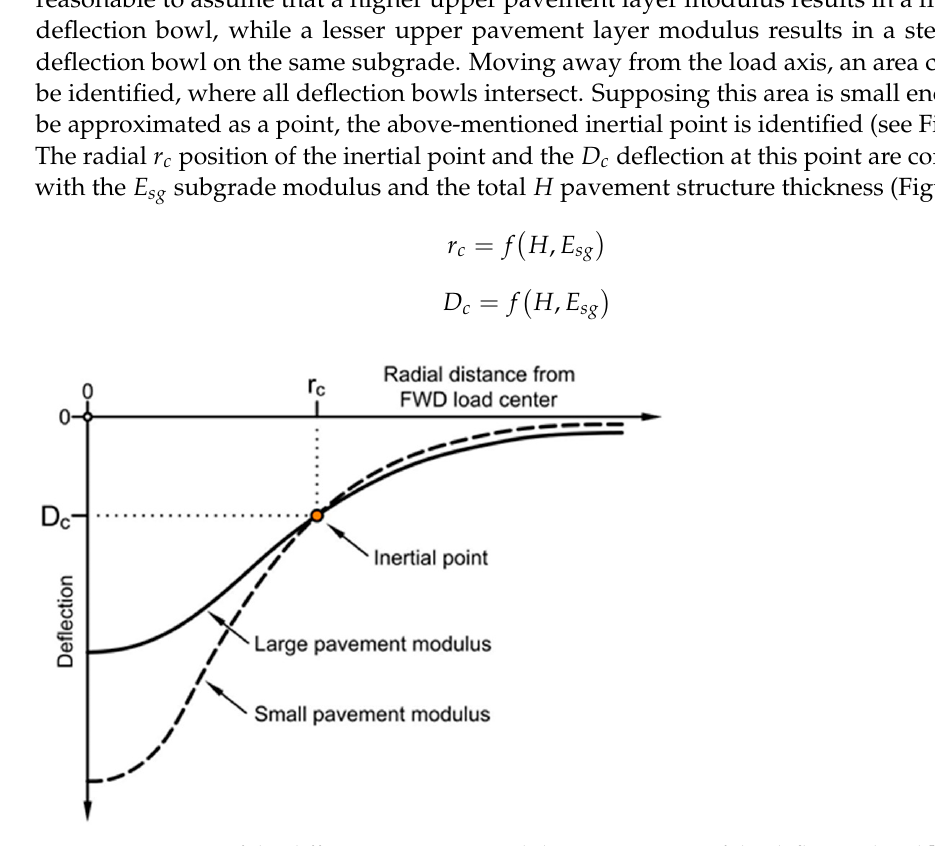
Figure 9. Relationships between 𝑟 (cid:3030) , 𝐷 (cid:3030) , and subgrade modulus [23]. The unique measured point ( 𝑟 (cid:3051) and 𝐷 (cid:3051) ), introduced by Noureldin and Sharaf, can be equivalent to the inertial point with a good approximation. Hereafter, it is referenced this way: